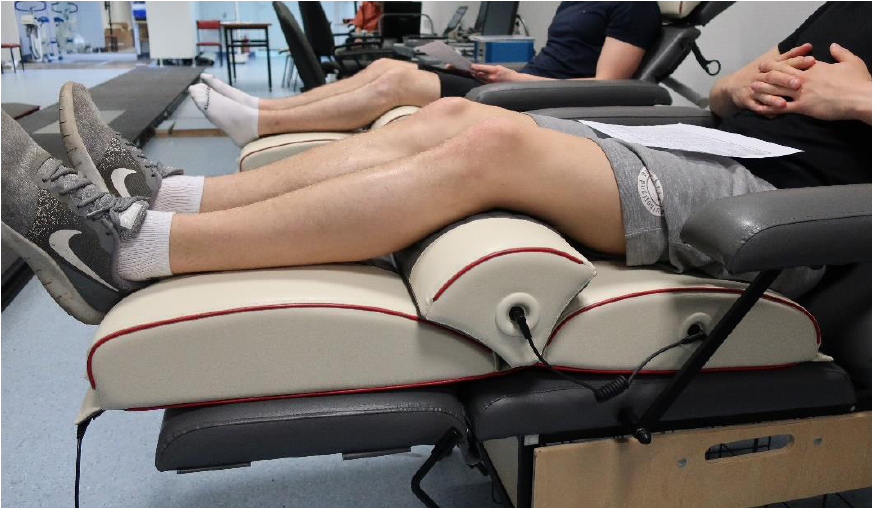
Figure 2. Position of the test subject during vibration massage application. Source: Figure taken by the authors of the paper.